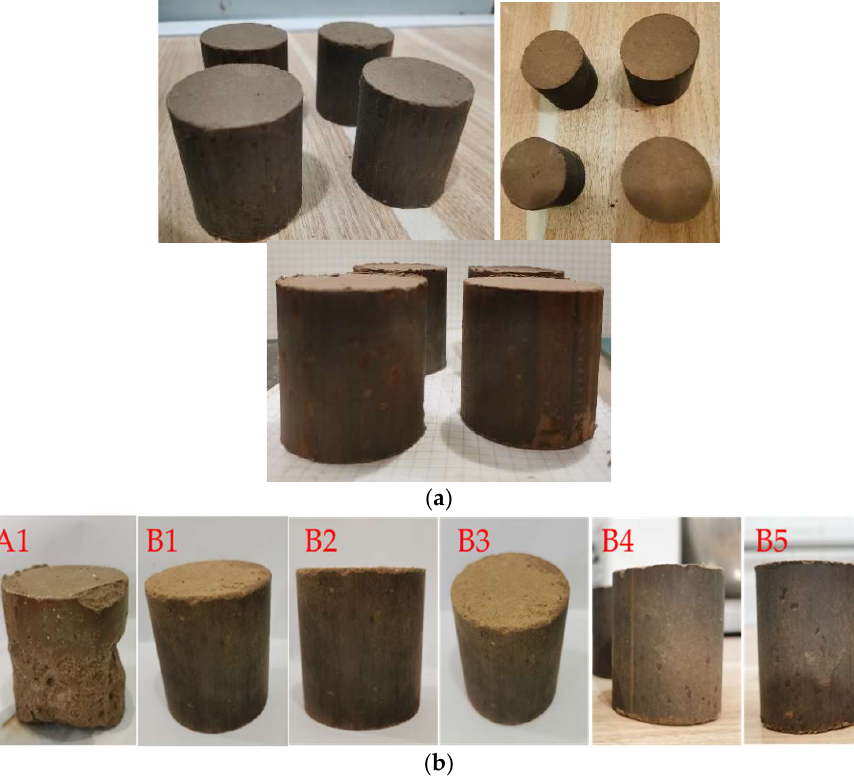
Figure 11. The samples before and after water curing ( a ) before water curing, ( b ) after water curing.